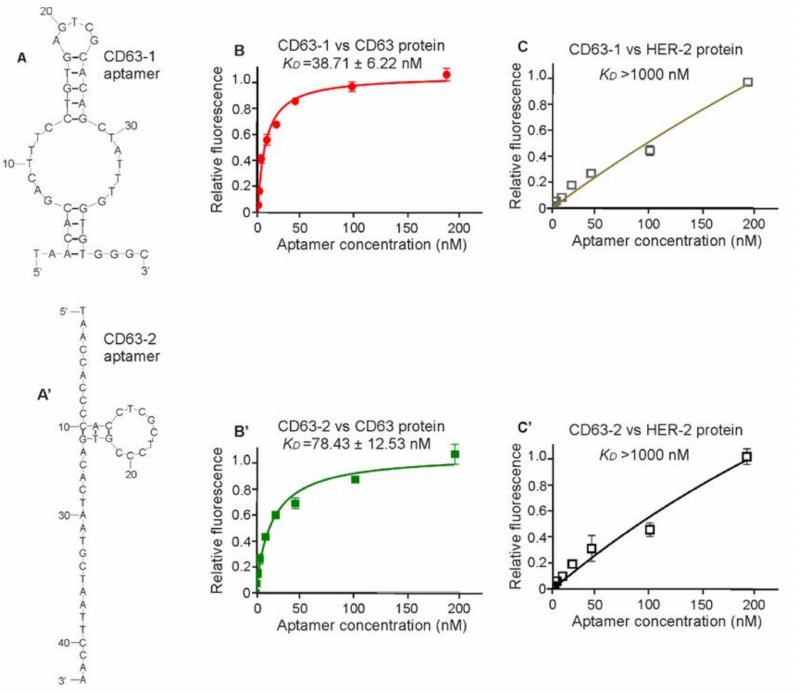
Figure2. Evaluationofthebindinga ffi nityofaptamerstoCD63protein. ( A , A’ ).Thepredictedsecondary structure of CD63-1 and CD63-2 aptamers using mfold program [36]; ( B , B’ ). Analysing equilibrium dissociation constants (Kd) of CD63-1 aptamer to CD63 molecule by ELISA; ( C , C’ ) Testing binding specificity of aptamers to CD63 with HER2 protein as negative control. All data were derived from triplicate tests. Before binding assay, excessive salmon sperm DNAs (10 µ g / 100 µ L / test) were employed to block the potential binding site of protein targets. Kd was calculated by GraphPad Prism program